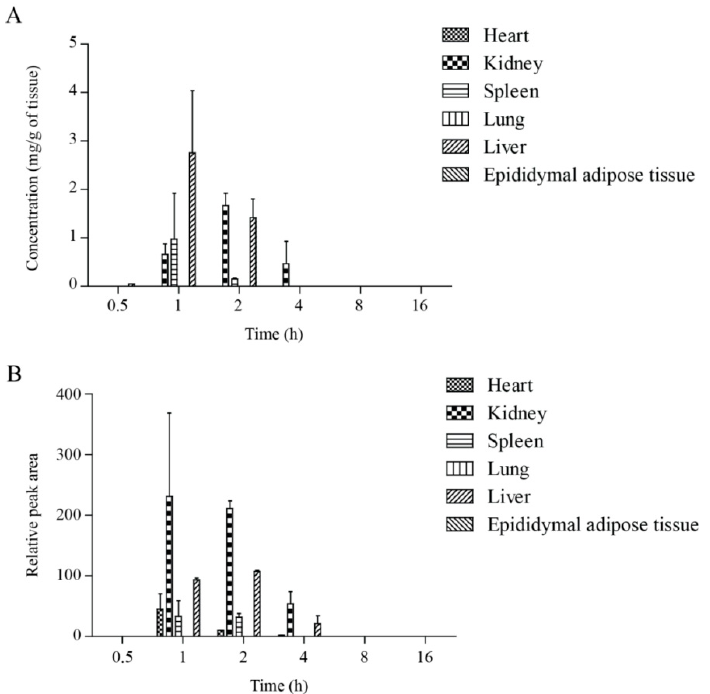
Figure 5. Tissue distribution of tyrosol-4-sulfate ( A ) and M2 ( B ). Tissue samples (heart, kidney, spleen, lung, liver, epididymal adipose tissue) were collected at different time intervals post-dosing (0, 0.5, 1, 2, 4, 8, and 16 h) and the concentration of tyrosol-4-sulfate and M2 was measured. Each point represents mean ± SD ( n = 3).